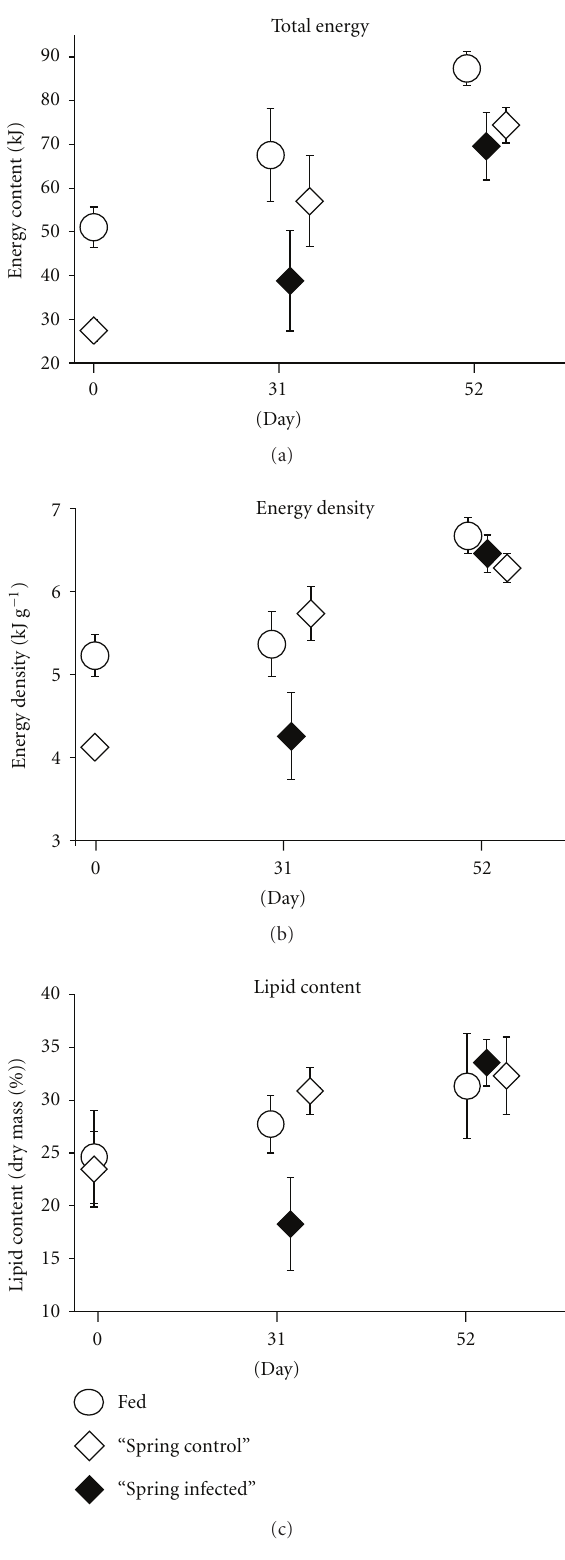
Figure 3: Compensatory response of young-of-the-year Pacific her- ring infected with Ichthyophonus depicted by total energy content, energy density, and lipid content (% dry mass). Fish represented in this figure were cultured in ambient water temperature (9.5 ◦ C). Low sample size of infected fish on day 31 precludes statistical